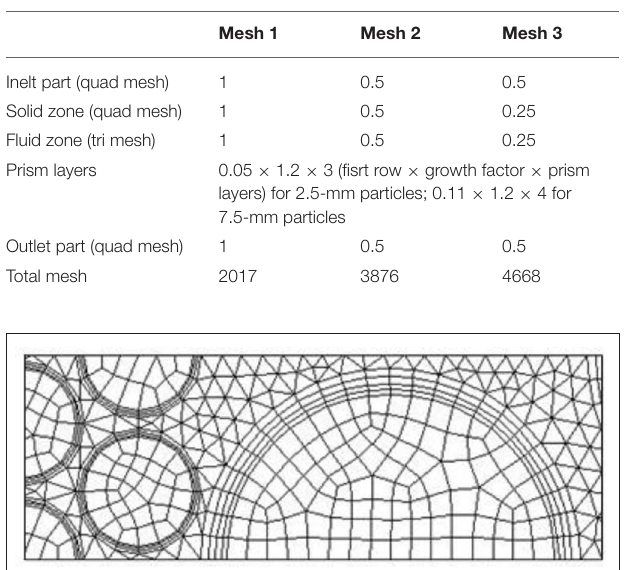
FIGURE 2 | Mesh in the vicinity of the interface between the two sections.